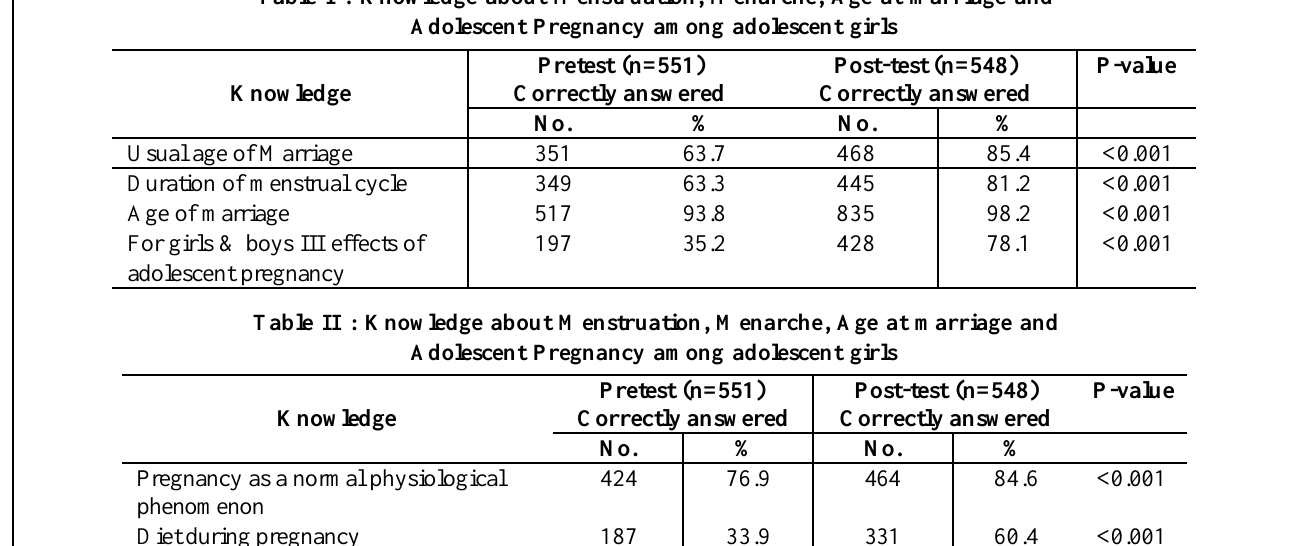
Table I : Knowledge about Menstruation, Menarche, Age at marriage and